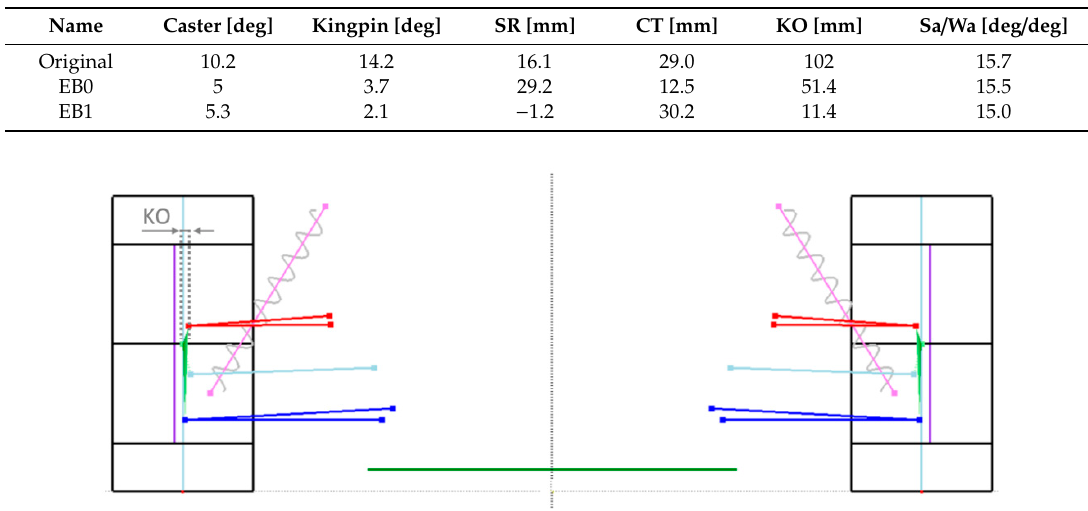
Table 2. New EB1 suspension compared with the previous ones.